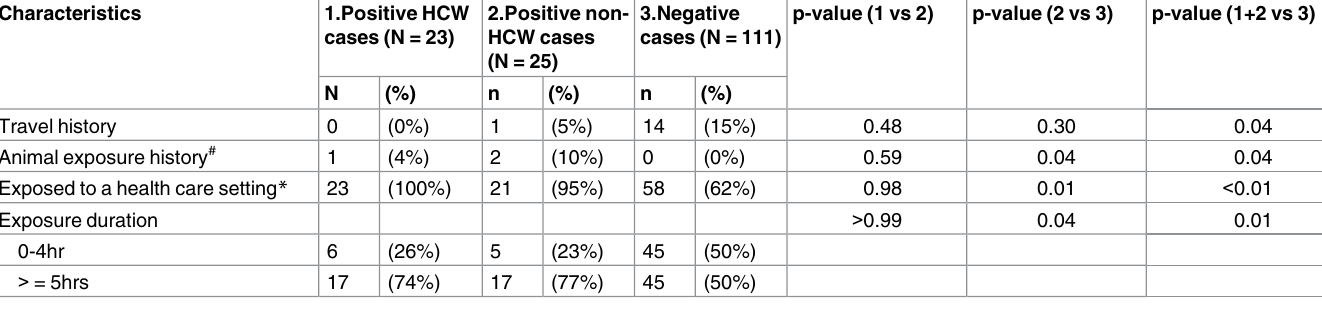
Table 2. Comparison of potential exposure factors among the three patient groups.